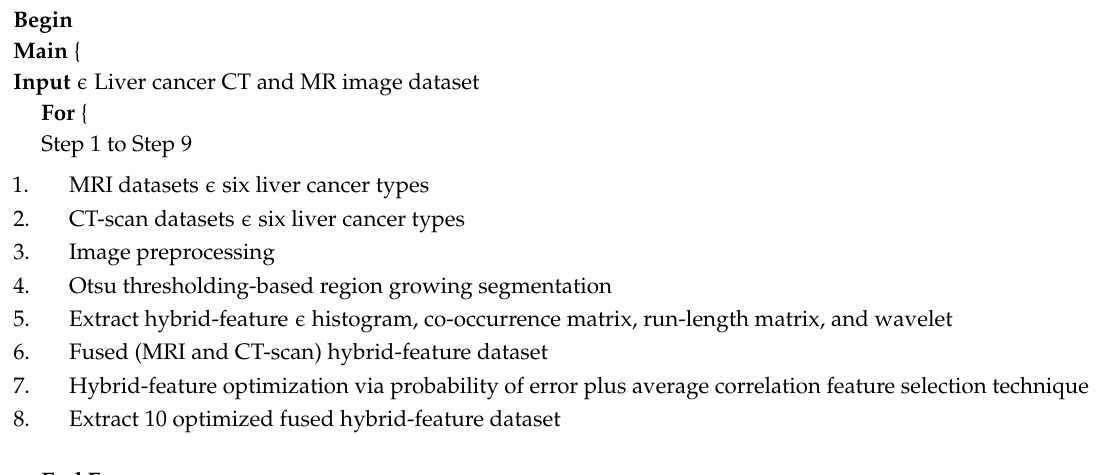
Algorithm 1. Otsu thresholding-based segmentation and fused hybrid-feature analysis for liver cancer classification proposed